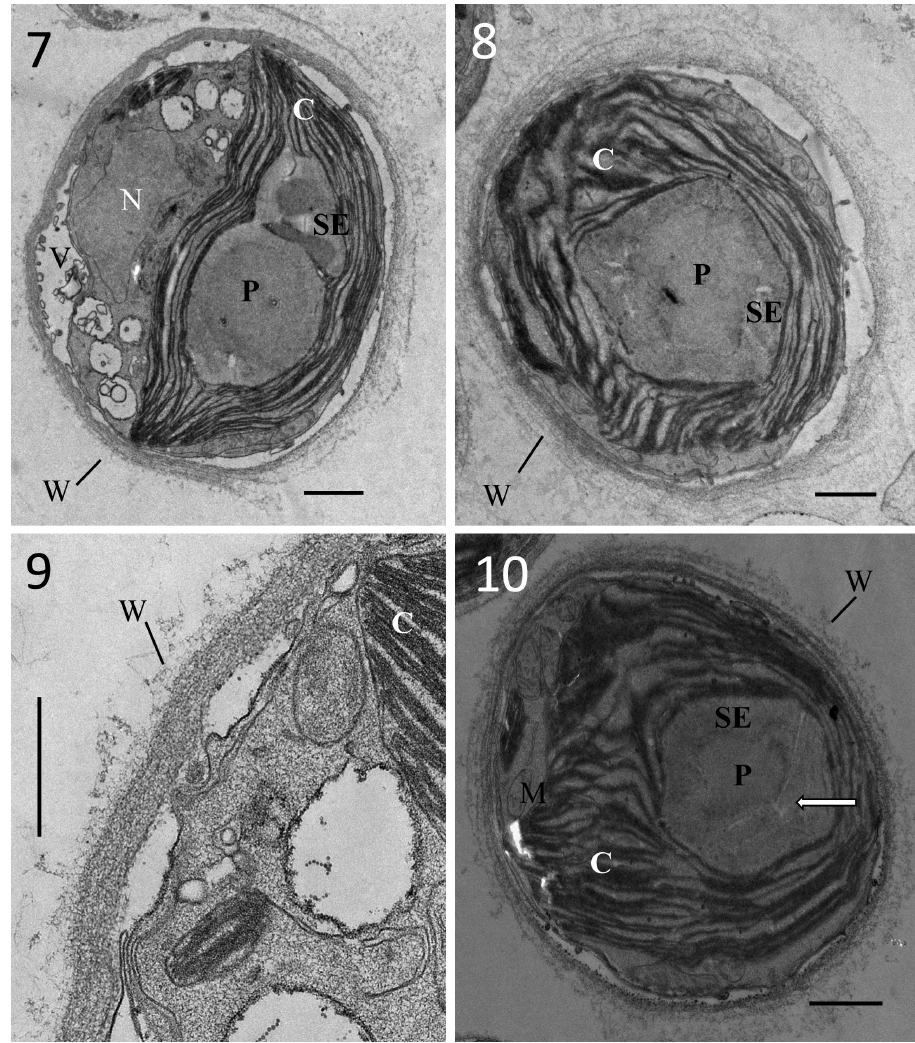
Figures 7–10. TEM images of Spongiosarcinopsis qinghaiensis sp. nov.: 7 cells contain one nucleus, one chloroplast, one pyrenoid covered by starch envelope 8 the starch envelope covering the pyrenoid is not obvious 9 unidentified gelatinous layer outside the cell wall 10 the pyrenoid is covered by segment- ed starch envelope and penetrated by straight thylakoids. C = chloroplast, N = nucleus, P = pyrenoid, SE = starch envelope of the pyrenoid, W = cell wall. Arrows indicate thylakoids penetrating into the pyr- enoid matrix. Scale bar: 1 μm ( 7, 8, 10 ); 500 nm ( 9